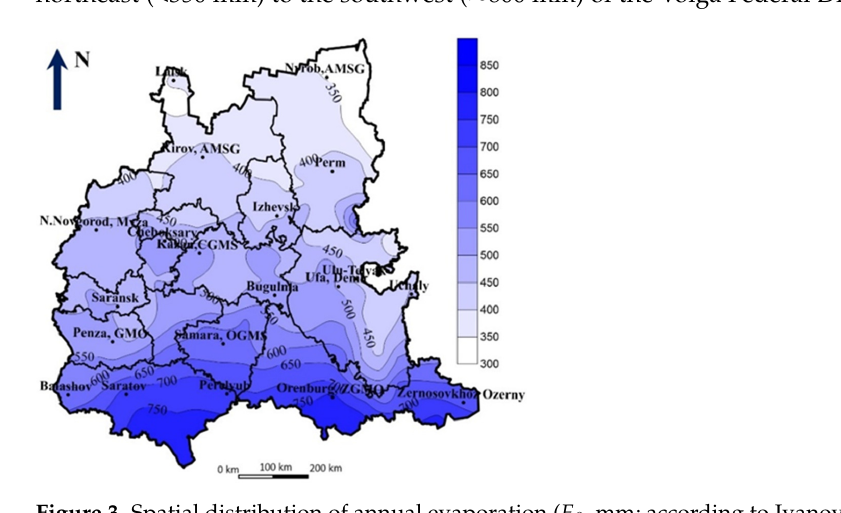
Figure 3. Spatial distribution of annual evaporation ( E 0 , mm; according to Ivanov’s method [21]) in the Volga Federal District.